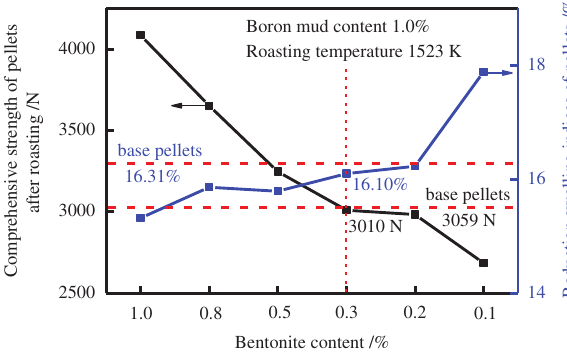
Figure 5: Effects of boron mud lessening bentonite content in pellets